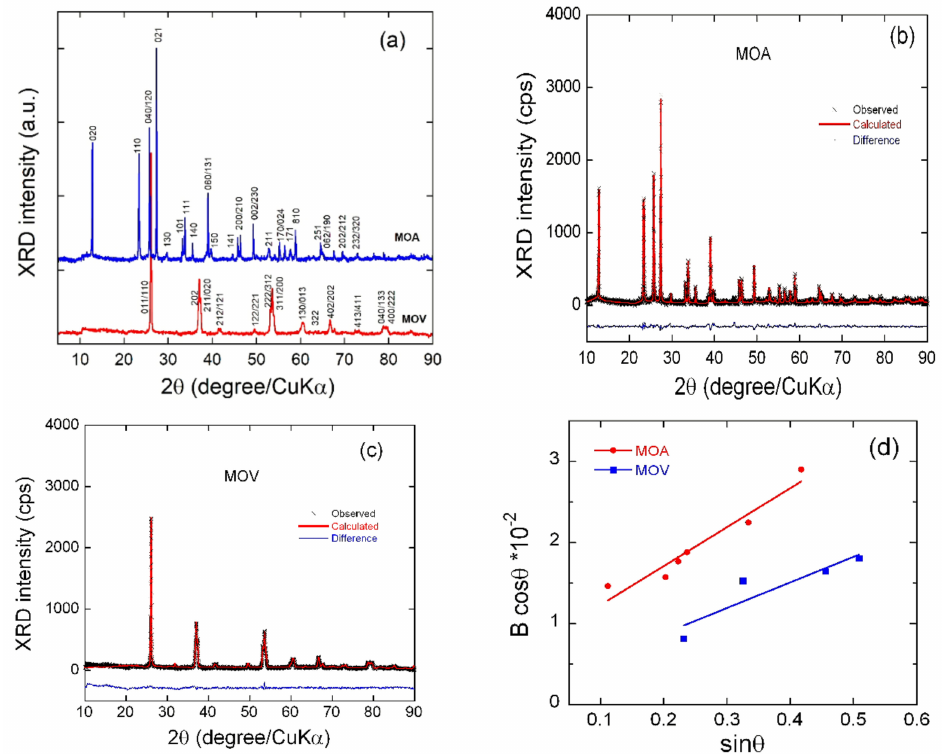
Figure 2. ( a ) XRD patterns of the as-prepared MOA and MOV samples. ( b ) Rietveld refinement of the MOA sample. ( c ) Rietveld refinement of the MOV sample. Cross marks are experimental data and solid lines (in red) are calculated diagrams. The curve at the bottom is the difference between the calculated and observed intensities. ( d ) Analysis of micro-strain from the full-width B at half-maximum of the XRD peaks according to Equation